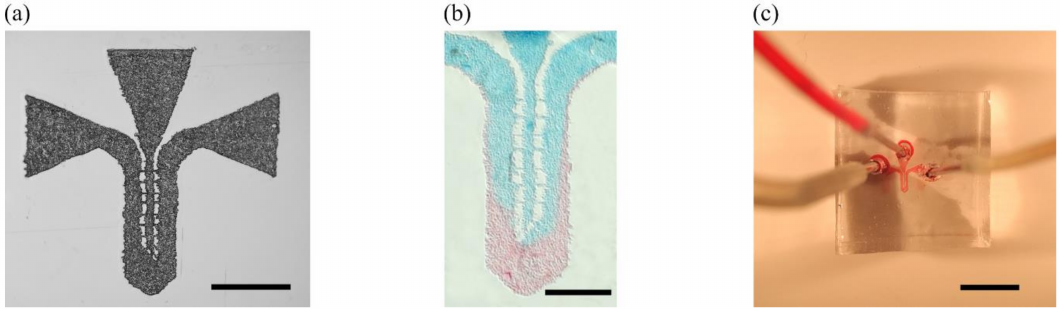
Figure 6. ( a ) Laser micropatterned PMMA mold for two-input two-output microfluidic channel design. ( b ) Example of colorant diffusion microfluidics inside PDMS microchannel for bonding validation. ( c ) Microfluidic device (Scale bars: ( a ) 1 mm, ( b ) 500 µ m, ( c ) 5